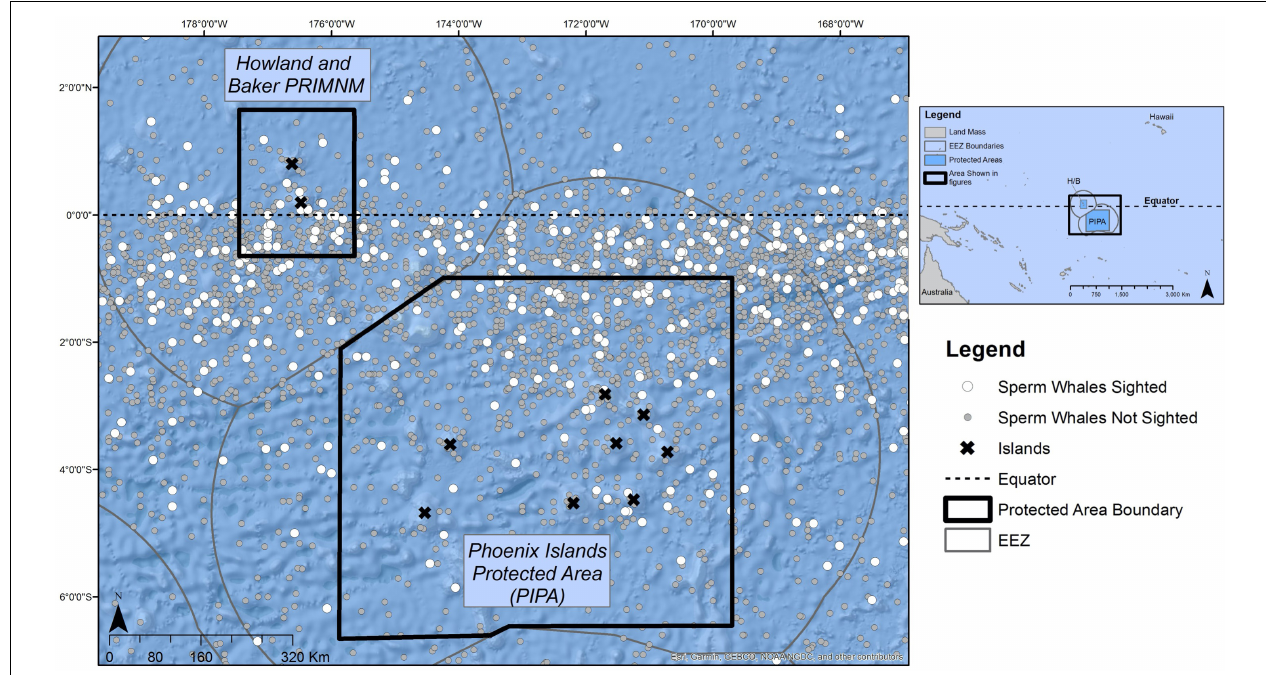
FIGURE 1 | Study area, with marine protected area borders outlined in black and historical whale records plotted with white dots (if whales sighted) and gray dots (no whales seen). Data from Smith et al. (2012).